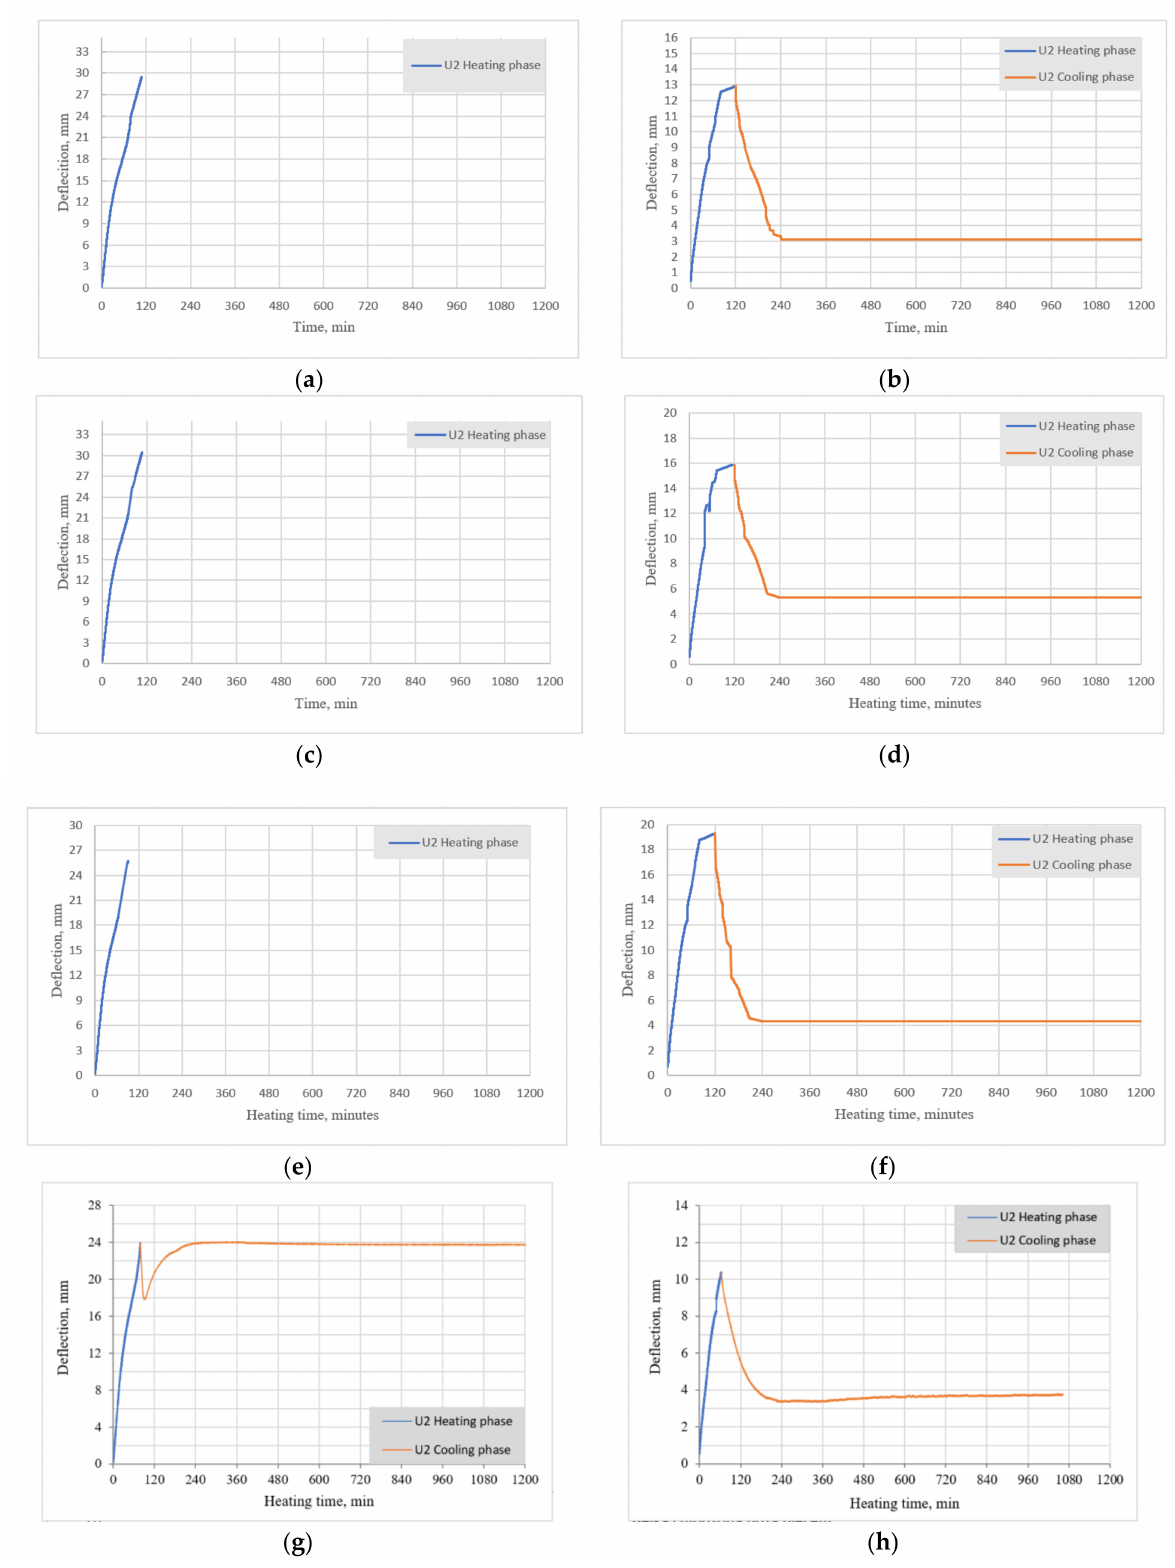
Figure 11. Mid-span deflections measured by U2 dial gauge for ( a ) set 1.1 (B2Ø14-beam 1); ( b ) set 1.2 (H2Ø14-beam 1); ( c ) set 1.1 (B2Ø14-beam 2); ( d ) set 1.2 (H2Ø14-beam 2); ( e ) set 1.1 (B2Ø14-beam 3); ( f ) set 1.2 (H2Ø14-beam 3); ( g ) set 1-prev (B2Ø14); ( h ) set 1-prev